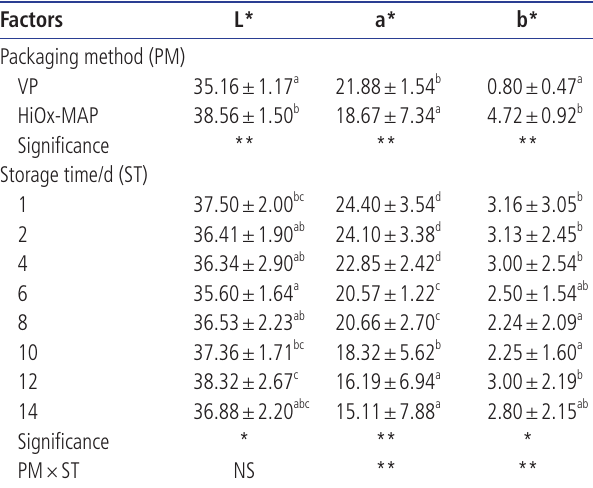
Figure 2. Effects of vacuum packaging (VP) and high-oxygen